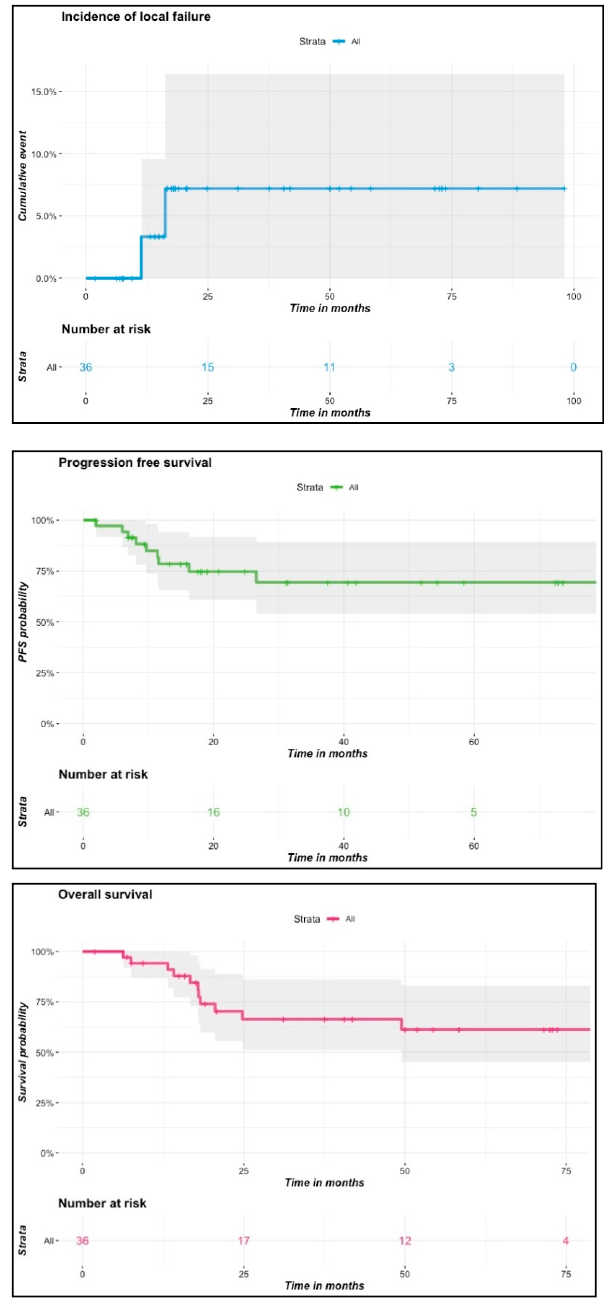
Figure 3. Incidence of local failures, progression-free survival and overall survival curves.